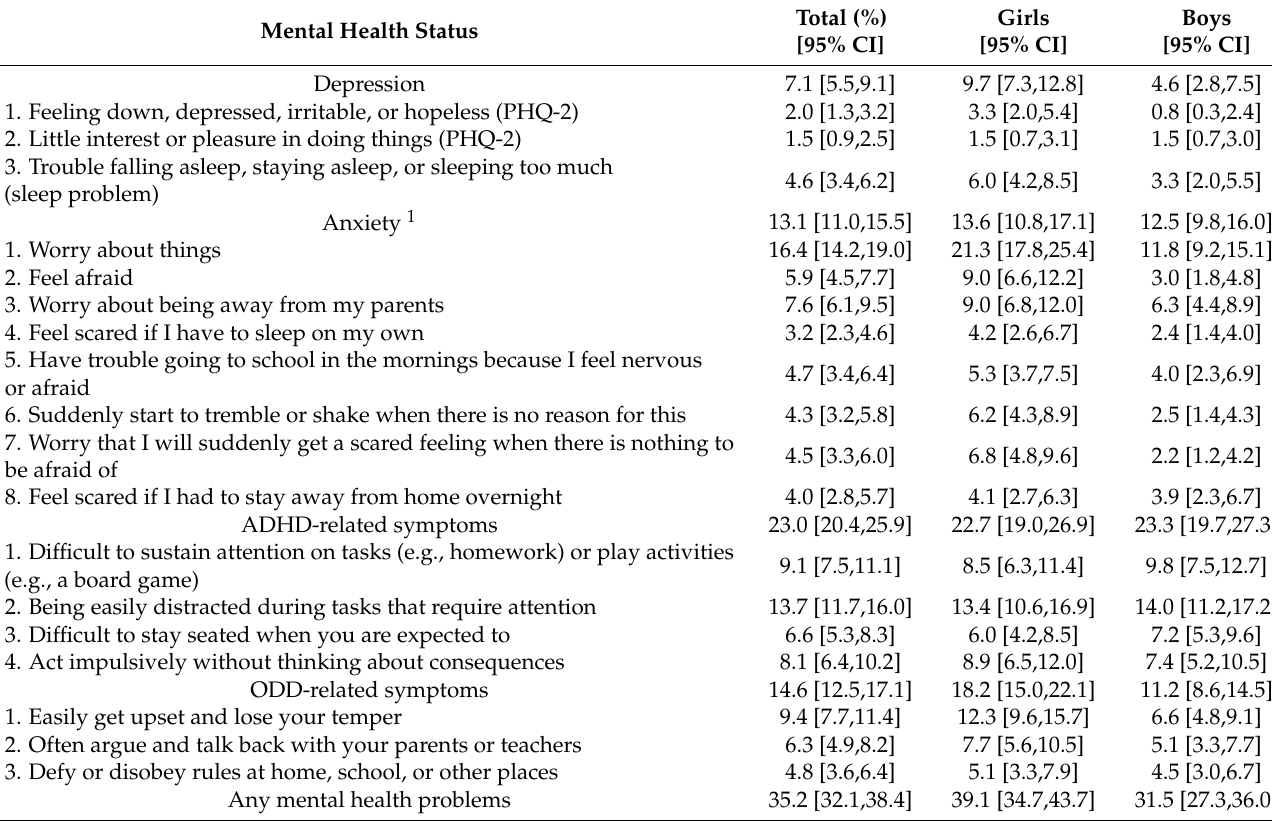
Table 4. Prevalence of mental health problems for children and